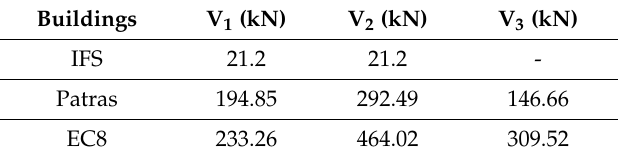
Table 13. Load on columns on one-story one bay approximated frames.